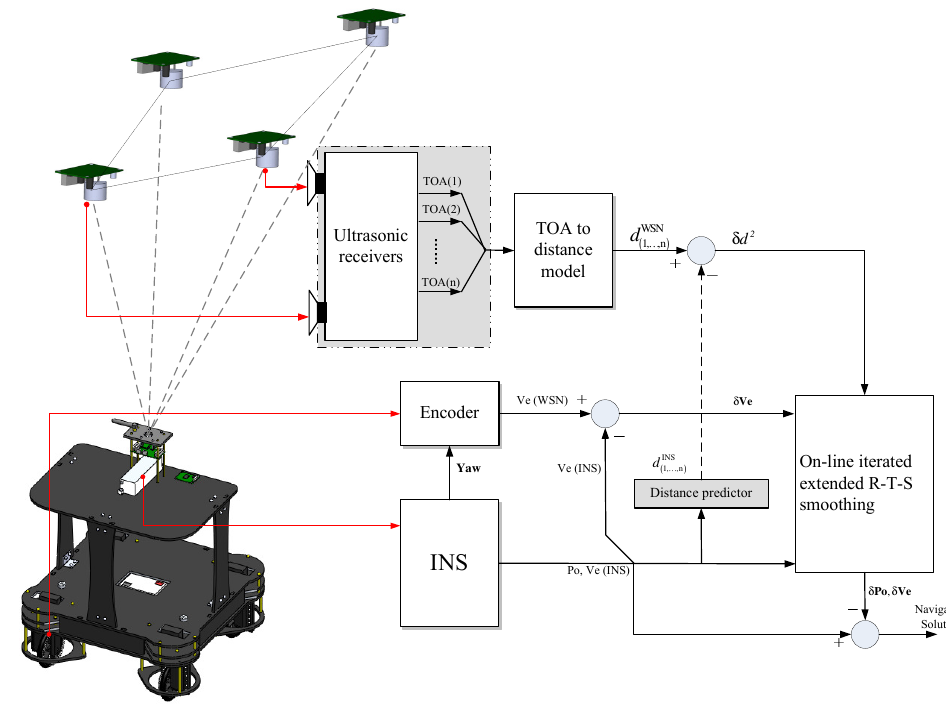
Figure 2. The configuration of the data fusion for the integrated navigation.